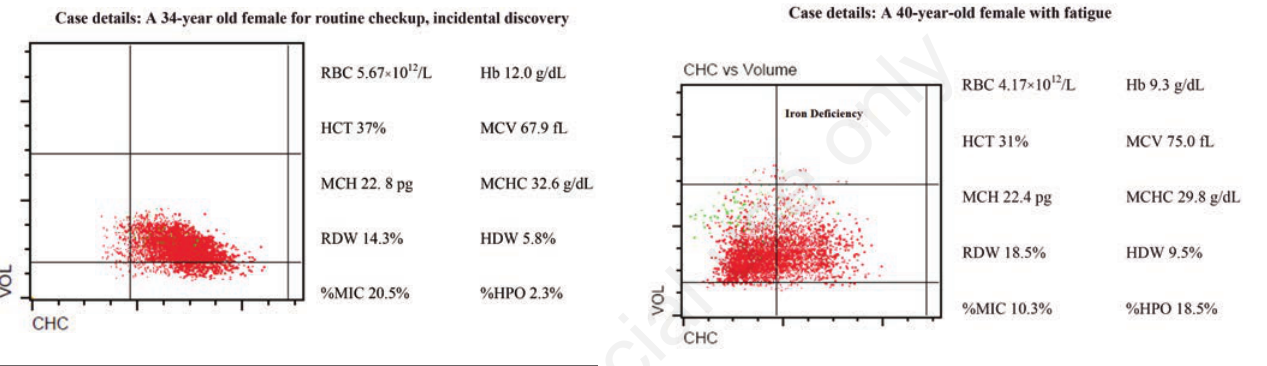
cells.Figure Figure 2. a -thalassemia trait. The pattern and explanation is the same as seen in b thalassemia carriers, Figure 1.